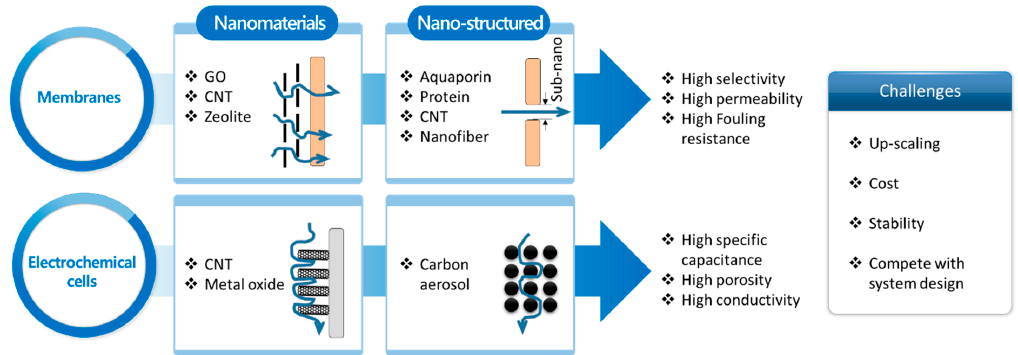
Figure 5. Current role and remaining challenges of nanotechnology for water desalination using membranes and electrochemical cells.